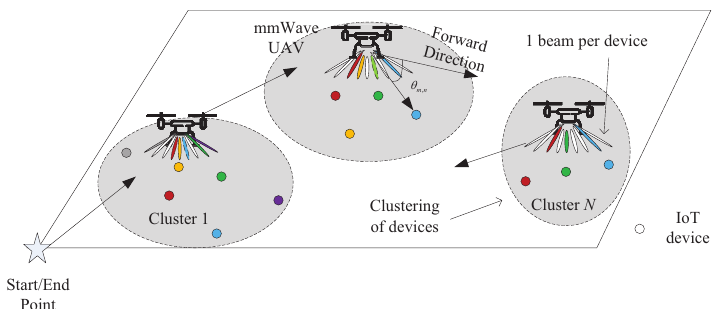
Figure 1. The proposed UAV-aided mmWave MIMO communication